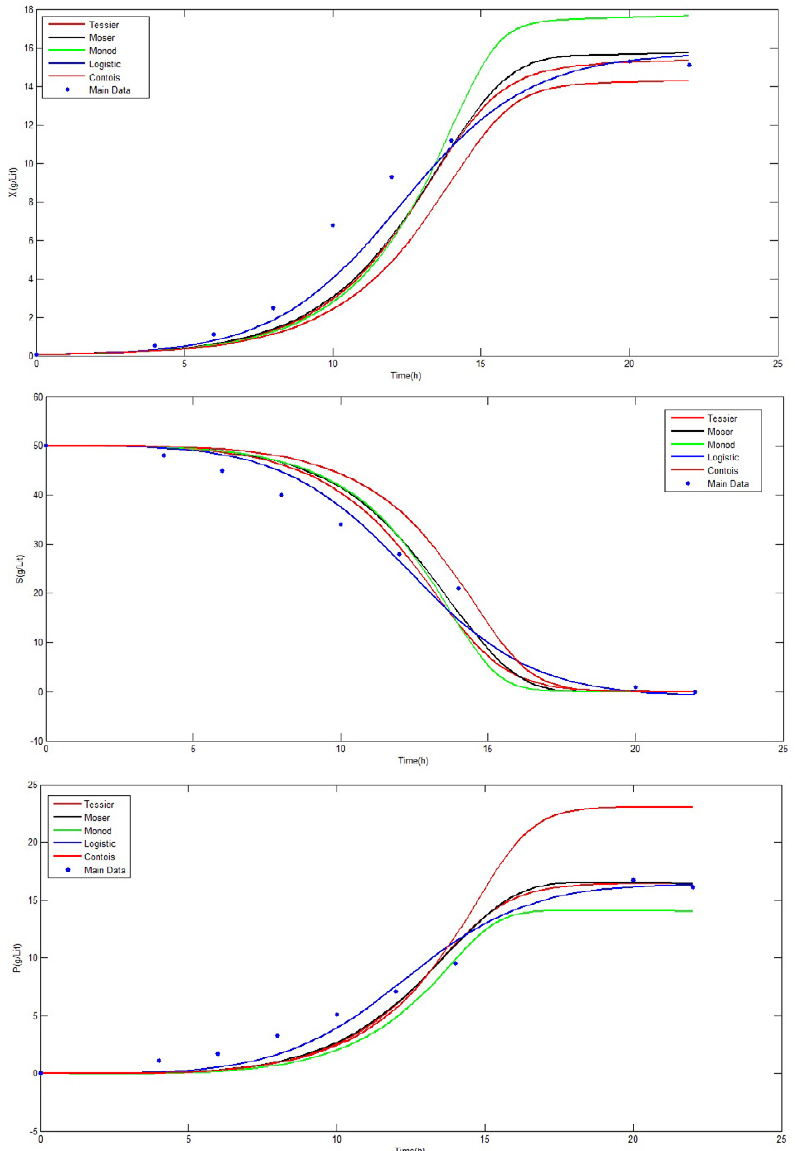
Fig. 5. Prediction of different models for (a) microorganisms, (b) substrates and (c) biosorption product in batch membrane reactors.